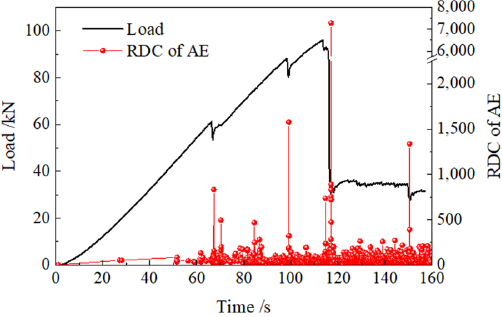
Figure 11. RDC of AE during loading of concrete samples.